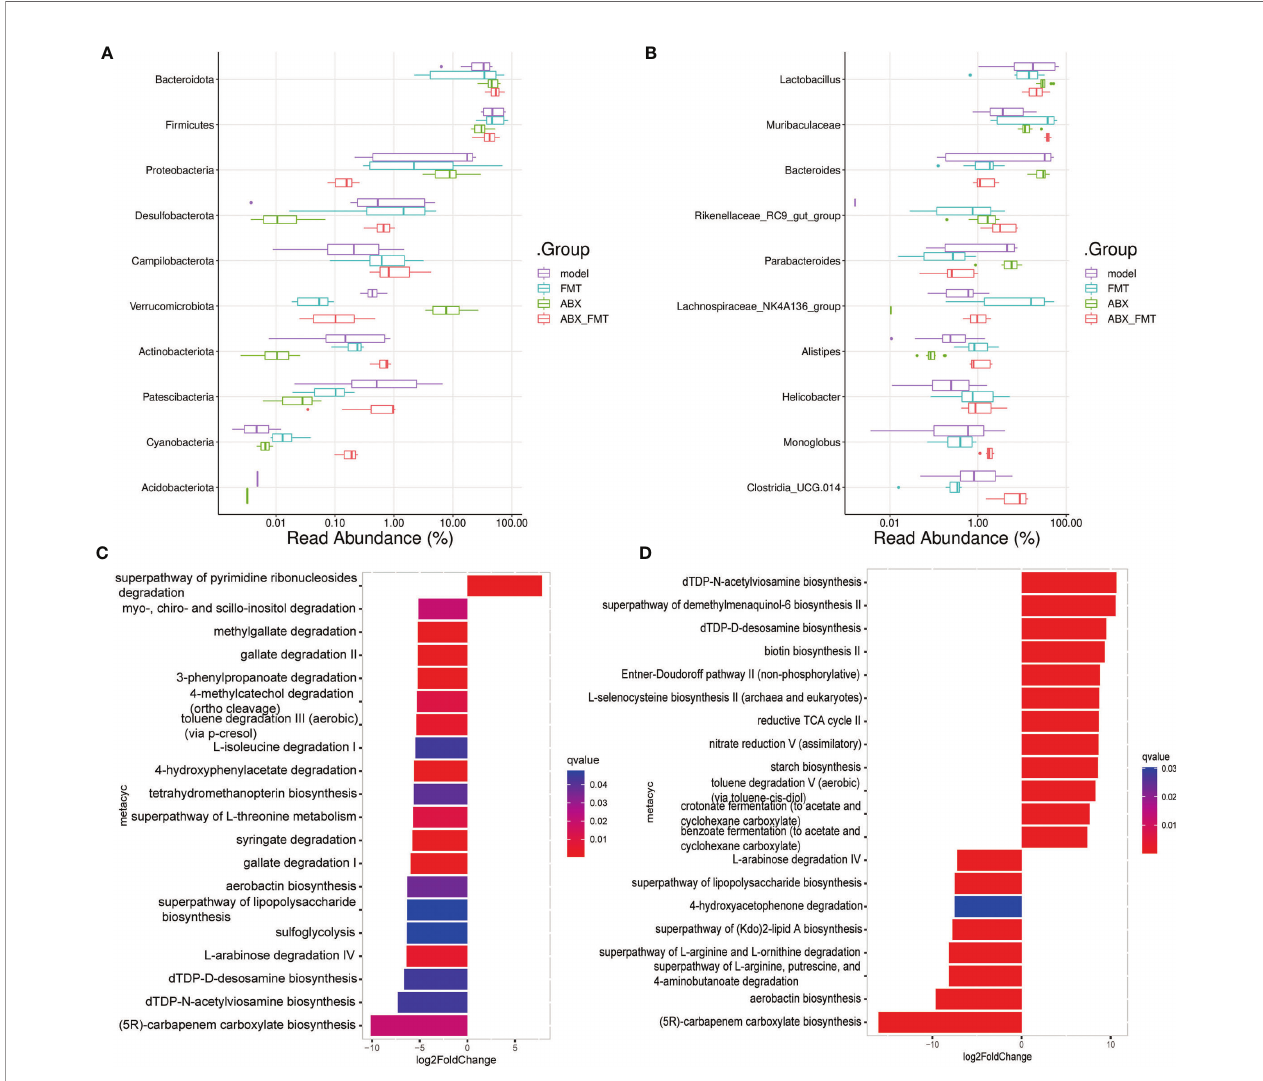
FIGURE 5 | FMT improved the function of gut microbiota in mice with acute pneumonia. (A, B) The histogram showed microbiota abundance at the phylum and genus level. (C) Differences in gut microbial functional pathways between model group and FMT group. (D) Differences in gut microbial functional pathways between ABX group and ABX_FMT group. N=5 sample/group for 16S rRNA